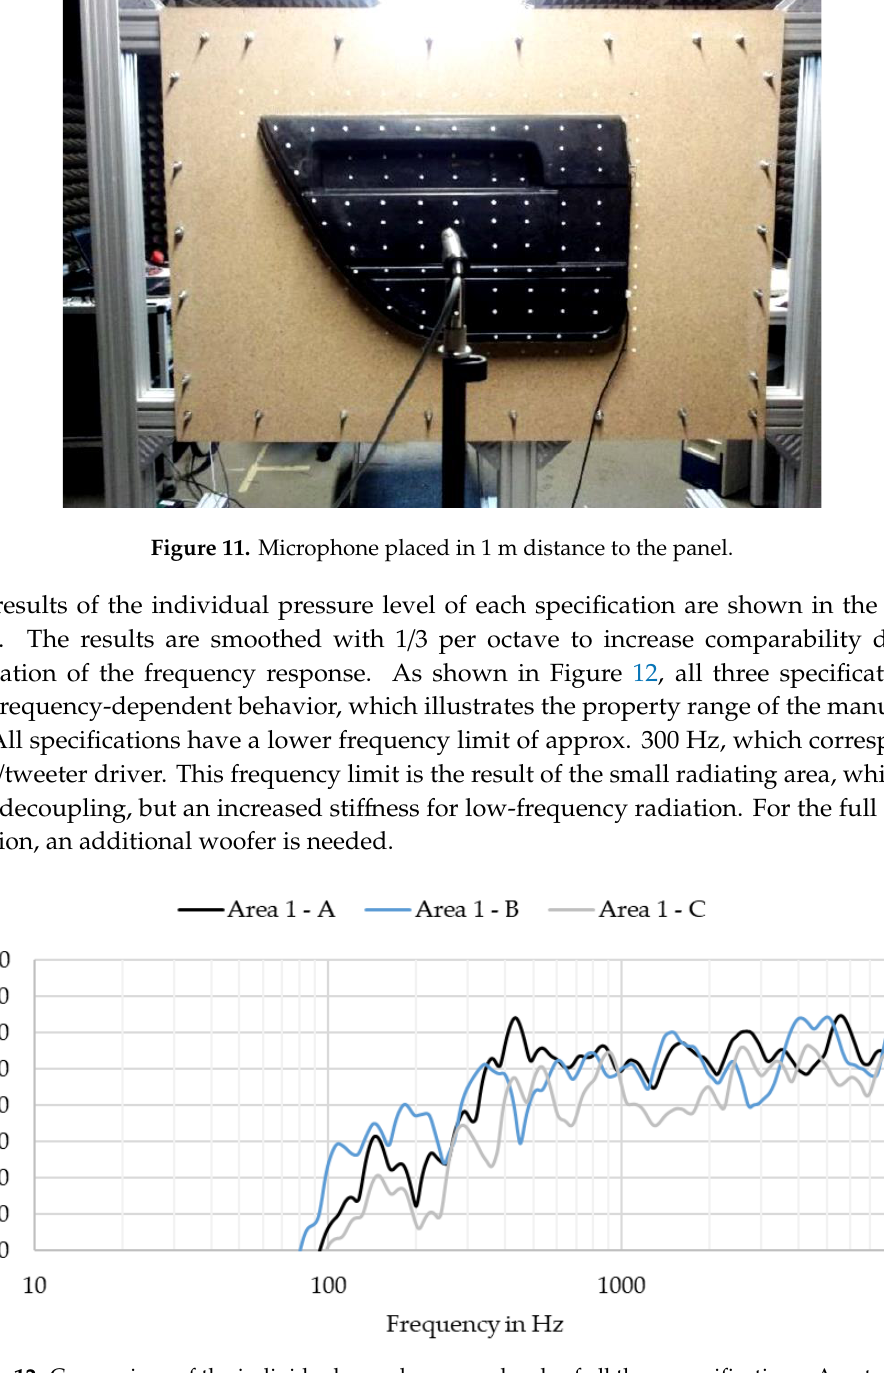
8 of 12 Figure 9. ( a ) Local fixation of the piezoelectric actuator, and ( b ) connecting cables in the mold cavity by means of a fast curing adhesive. When producing the specification with textile reinforcement, the piezoelectric actuator is placed on the fabric. After the components have been positioned in the mold, the assembly gets backfoamed with the glass-fiber polyurethane mixture. As a result of the expansion process during curing, the fabric is infiltrated with the PUR matrix, creating a continuous fiber-reinforced composite in this area, Figure 10b. ( a ) ( b ) Figure 10. ( a ) Piezoelectric actuator placed on the carbon fabric just before embedding, and ( b ) textile- reinforced composite after curing. 5. Validating Tests of the Final Design This section analyzes the range of properties achieved in the LFI-manufacturing process and their influence on the acoustic behavior. Furthermore, recommendations for specific material